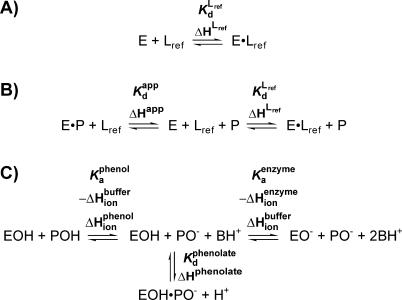
Determination of Thermodynamic Values for Phenolate Binding to KSI